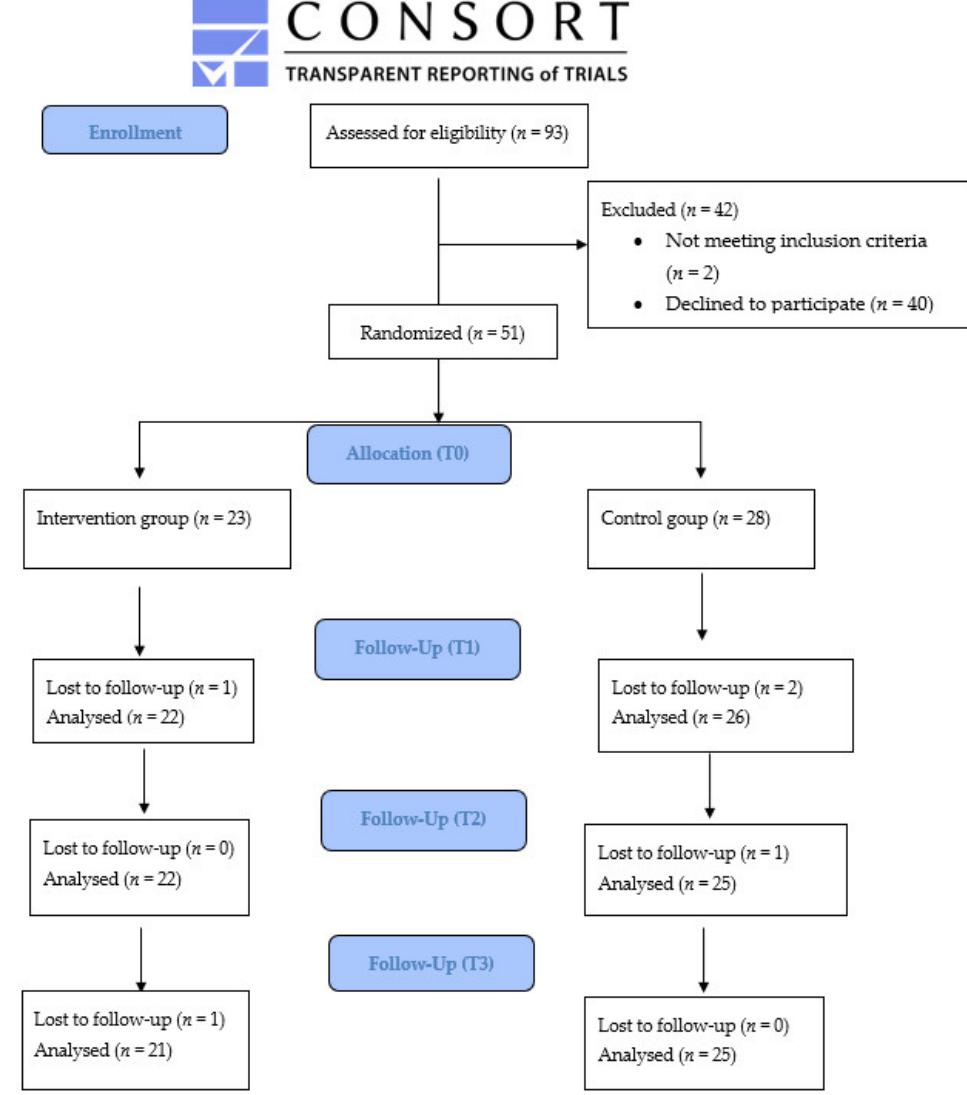
Figure 1. CONSORT flow diagram of the trial.